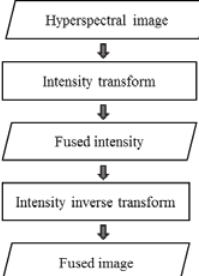
Figure 4. Overall workflow of sharpening hyperspectral images In the sharpening procedure, the intensity transformation section has two options: IHS transformation or HCS transformation. No matter which option is taken, the intensity derived is then transformed into frequency domain by a fast Fourier transformation. Later, the high frequency component of the target image will be filtered out by a low-pass filter and replaced by the high frequency component from an image with higher resolution. intensity enhancement procedure.